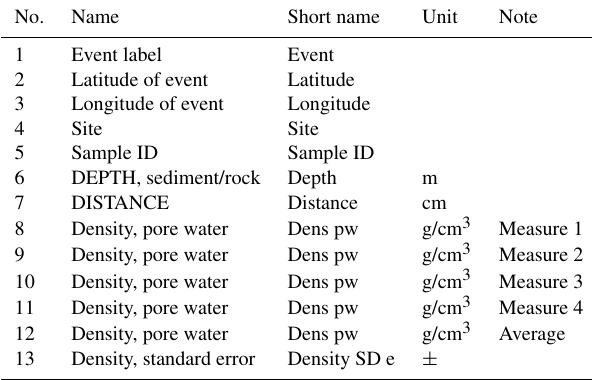
Table 8. Structure of the pore water density data sets at PANGEA (Lasser and Goehring, 2020a). The data include site and sample labels, the depth of each water sample (typically at the water table height), and its horizontal location along the transect as well as all individual density measurements and the averages and standard deviations for each sample.